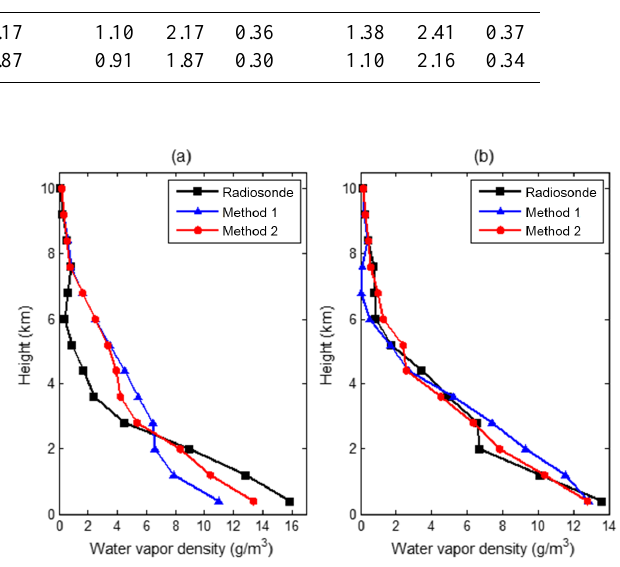
Figure 14. Water vapor profiles derived from radiosonde and two methods, (a) and (b) are periods of 12:00–12:30UTC 19 May and 00:00–00:30:00UTC 25 May 2015,